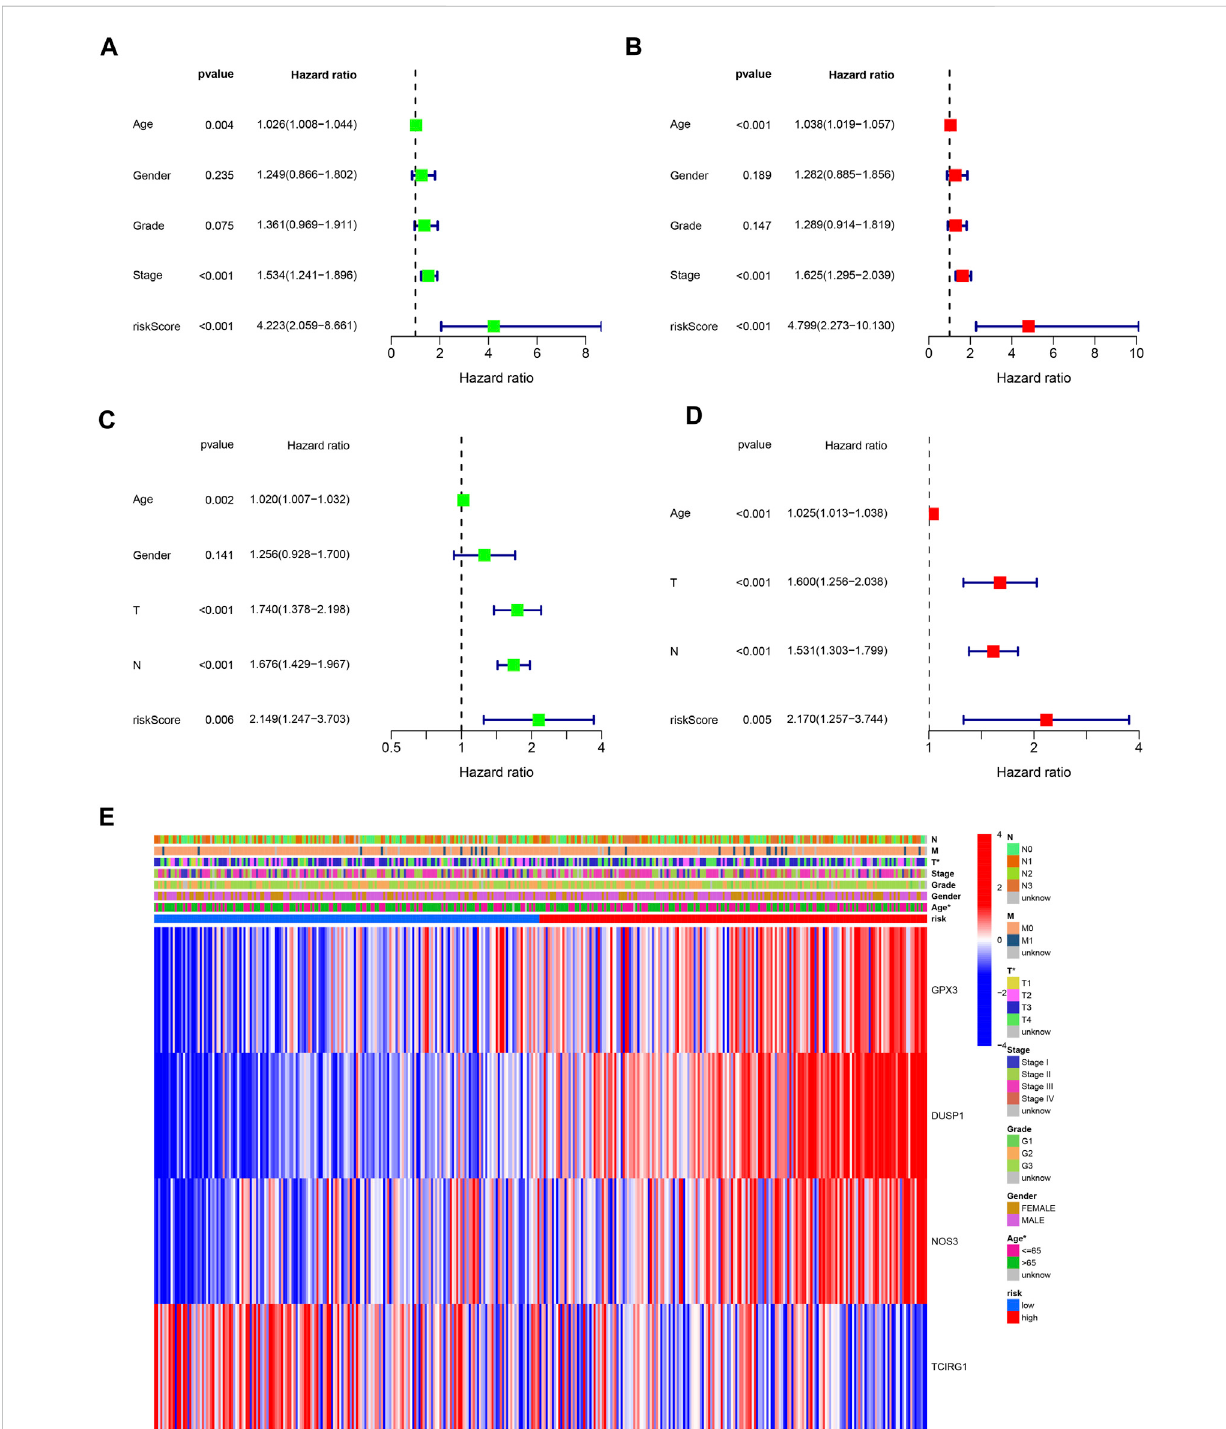
FIGURE 6 Independently predictive ability of the signature. (A, B) Univariable and Multivariable analysis across TCGA dataset. (C) Univariable analysis across GSE84437 dataset. (D) Multivariable analysis of the signature across GSE84437 dataset. (E) A heatmap for the correlation of the signature with clinical